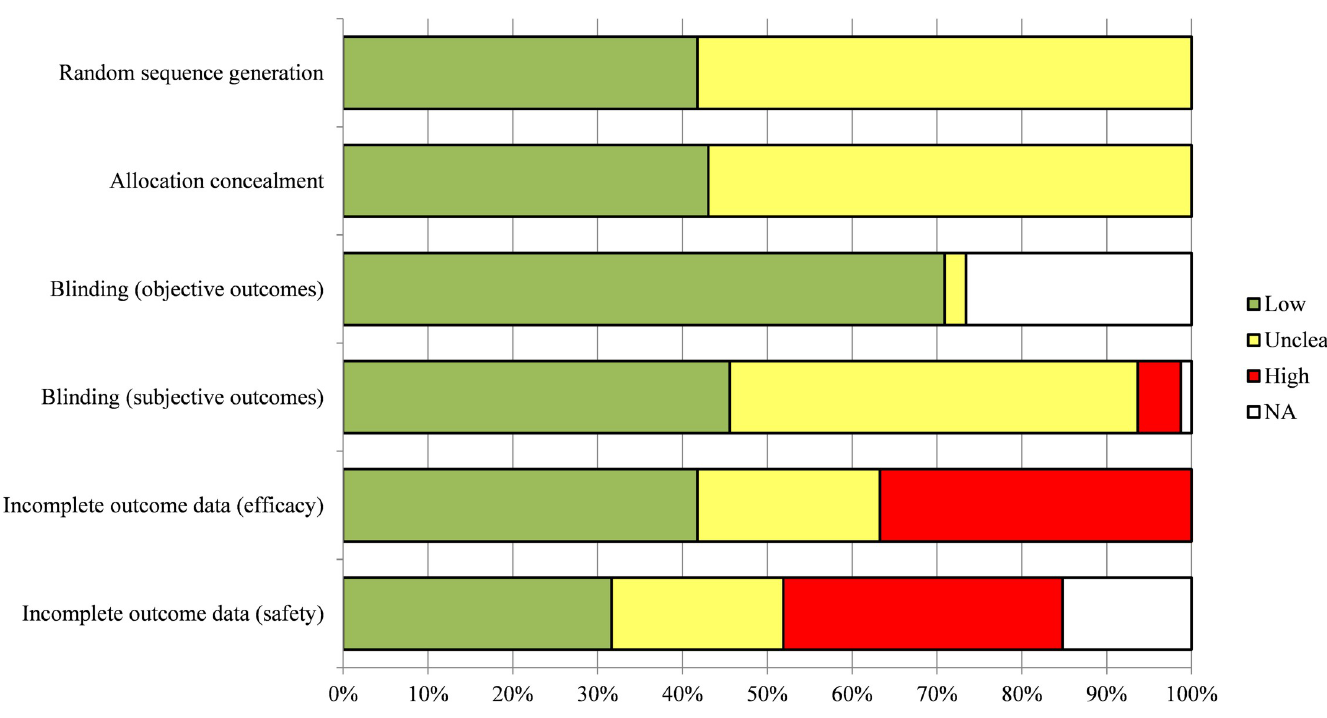
Fig 2. Risk of bias of included randomized controlled